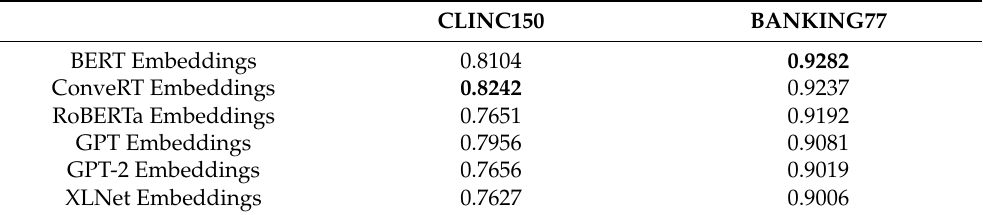
Table 2. Intent classification accuracy obtained by using different language model features extracted from the user input text. Best performing models for each dataset have their results in bold.